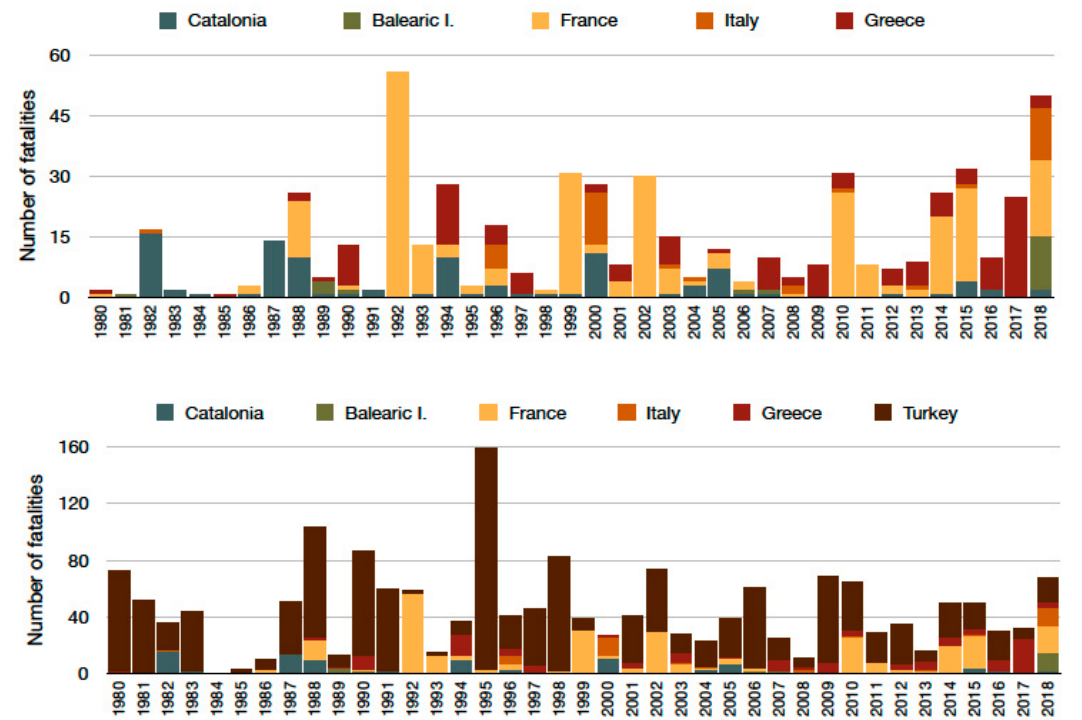
Figure 18. Yearly evolution of mortality by region (without Turkey above and including Turkey below) (we separated results with and without Turkey because the high number of deaths in Turkey does not allow seeing the distribution of annual mortality in the other countries).